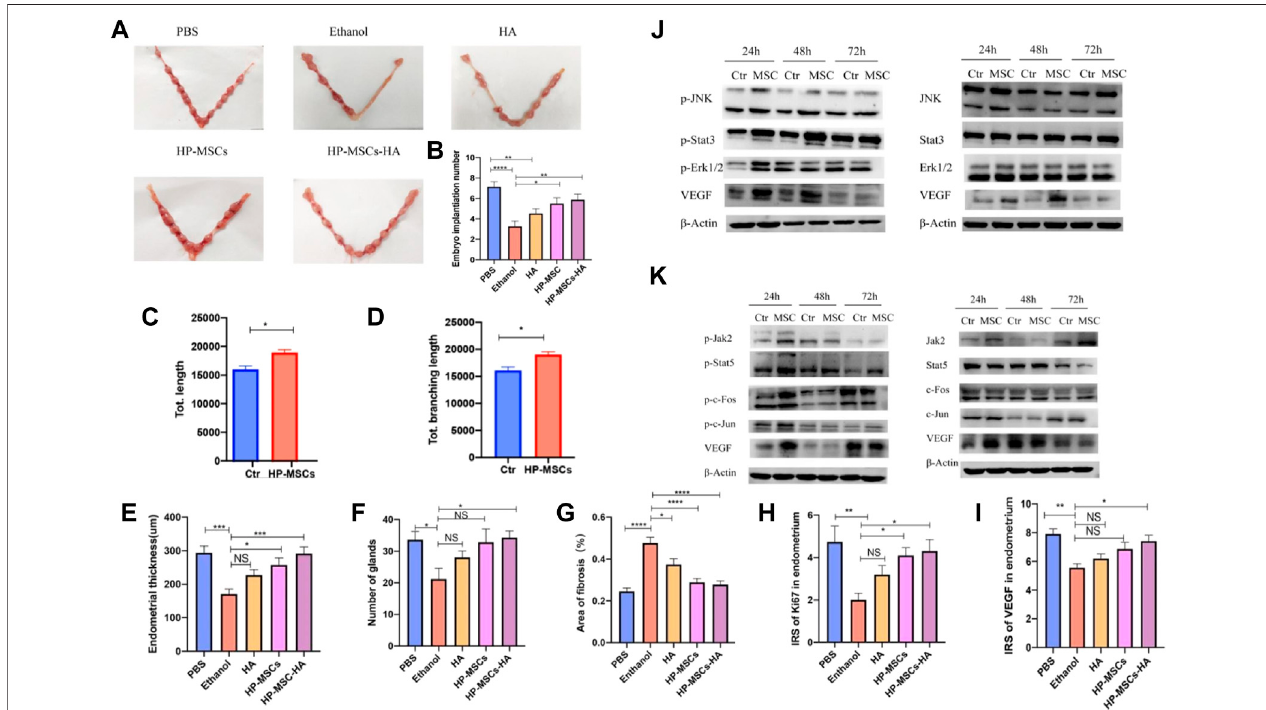
FIGURE 2 | (A,B) Evaluate the endometrial receptivity of the fi ve mouse groups with different treatments by the number of implanted embryos. (C,D) Quantitative assayoftubeformationassayanddatawereexpressedasmean±SEM.*indicates p < 0.05. (E) Averageendometrialthicknessandstatisticalanalysis(±SEM)ofthe fi ve groups. * indicates p < 0.05, ** indicates p < 0.01, *** indicates p < 0.001, n = 6. (F) Average gland number and statistical analysis (±SEM) of the fi ve groups. * indicates p < 0.05,n=6. (G) Average fi brosisareaandstatisticalanalysis(±SEM)ofthe fi vegroups.Theratioofthe fi broticarea=endometrial fi broticarea/endometrialarea.* indicates p < 0.05,**indicates p < 0.01,***indicates p < 0.001,****indicates p < 0.0001,n=6. (H) StatisticanalysisofIRSofKi67intheendometriumofthe fi vegroups.* indicates p < 0.05, **indicates p < 0.01, n=6. (I) StatisticanalysisofIRSofVEGFintheendometrium ofthe fi ve groups. *indicates p < 0.05,** indicates p < 0.01,n =6. (J) p-JNK, p-Stat3, p-Erk1/2, VEGF, and corresponding total protein western blot analysis at 24 h, 48 h, and 72 h, respectively, after culturing without and with HP- MSCs, respectively. (K) p-Jak2, p-Stat5, p-c-Fos, p-c-Jun, VEGF, and corresponding total protein western blot analysis at 24 h, 48 h, and 72 h, after culturing